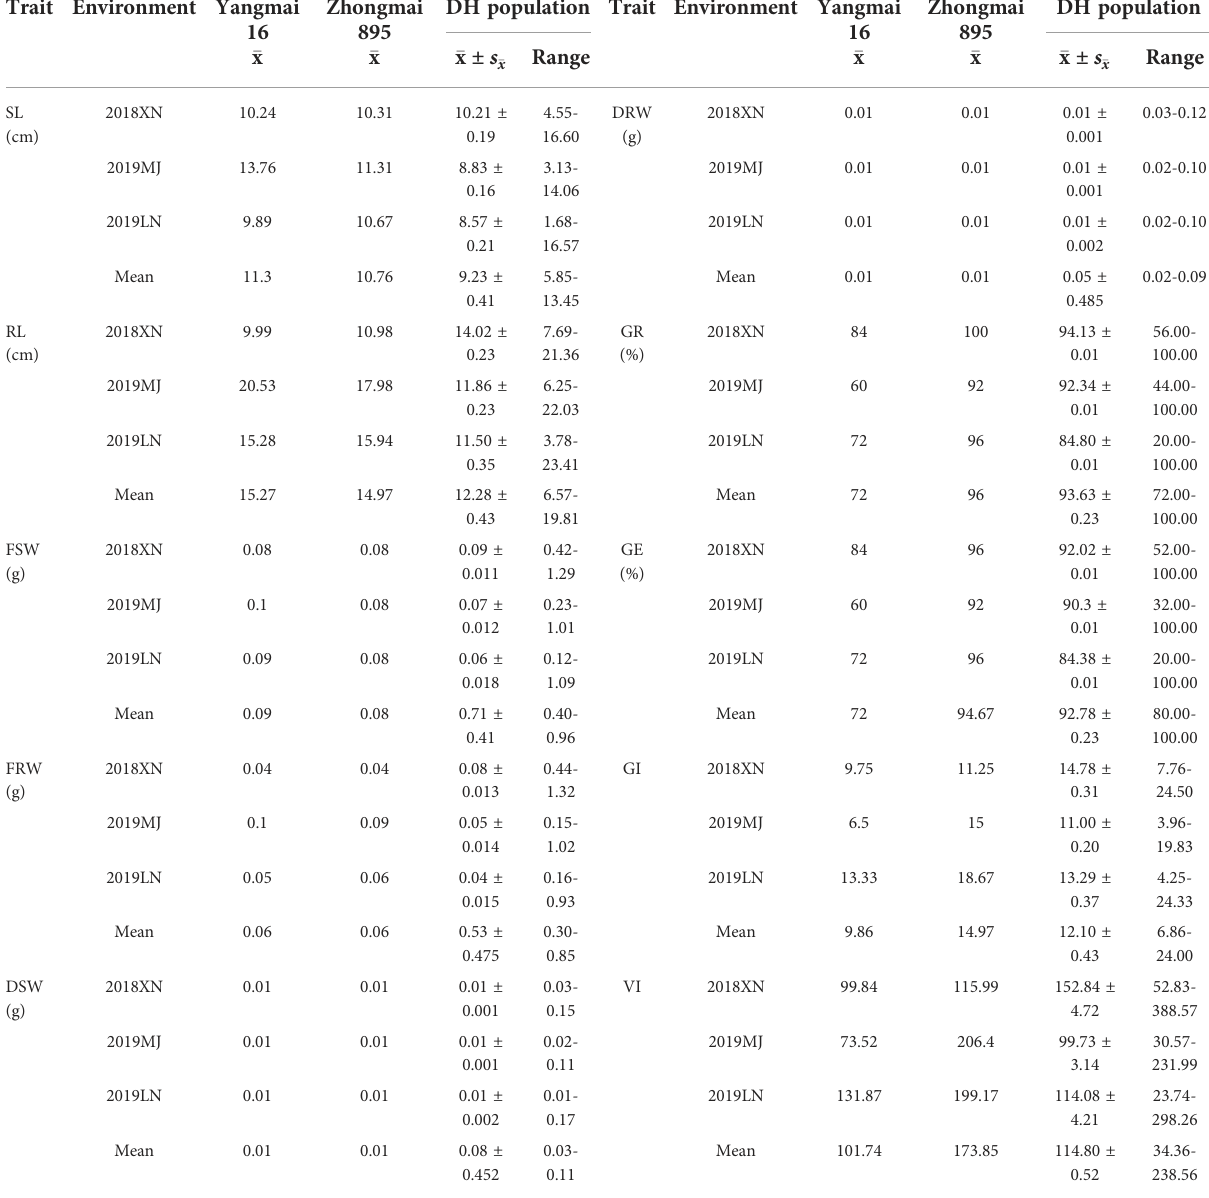
TABLE 1 Phenotypes of seed vigor related traits of Yangmai 16, Zhongmai 895, DH lines in three environments and the mean values. Trait Environment